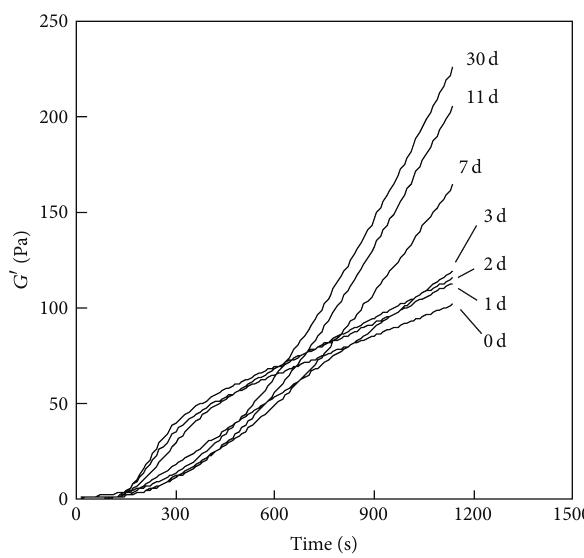
Figure 12: Storage modulus ( G 󸀠 ) of the 0.25% PSC/10mM genipin solution measured by a temperature-responsive gelation test. The numbers in the figure indicate the elapsed days after the preparation of genipin solution. The curves obtained at 37 ∘ C after the intervals of 600 s at 25 ∘ C were